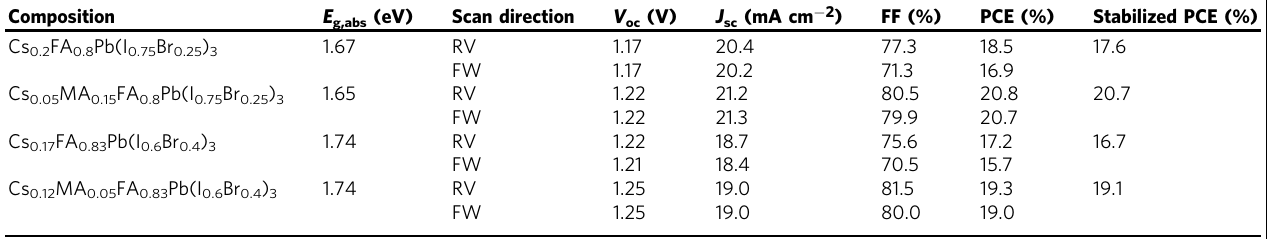
Table 1 Photovoltaic performance of best-performing wide-bandgap perovskite solar cells with and without MA cation Composition E g,abs (eV)